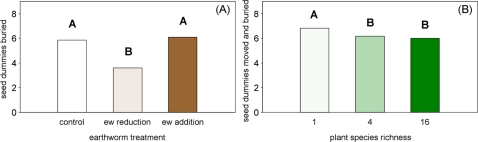
Seed dummies.(A) Effects of earthworm treatment (control, earthworm [ew] reduction, and earthworm addition) on the number of buried seed dummies after seven days (May 2006) and (B) effects of sown plant species richness (1, 4, and 16-species mixtures) on the number of moved and buried seed dummies after seven days (May 2006). Means with different letters vary significantly (Tukey's HSD test, α<0.05).